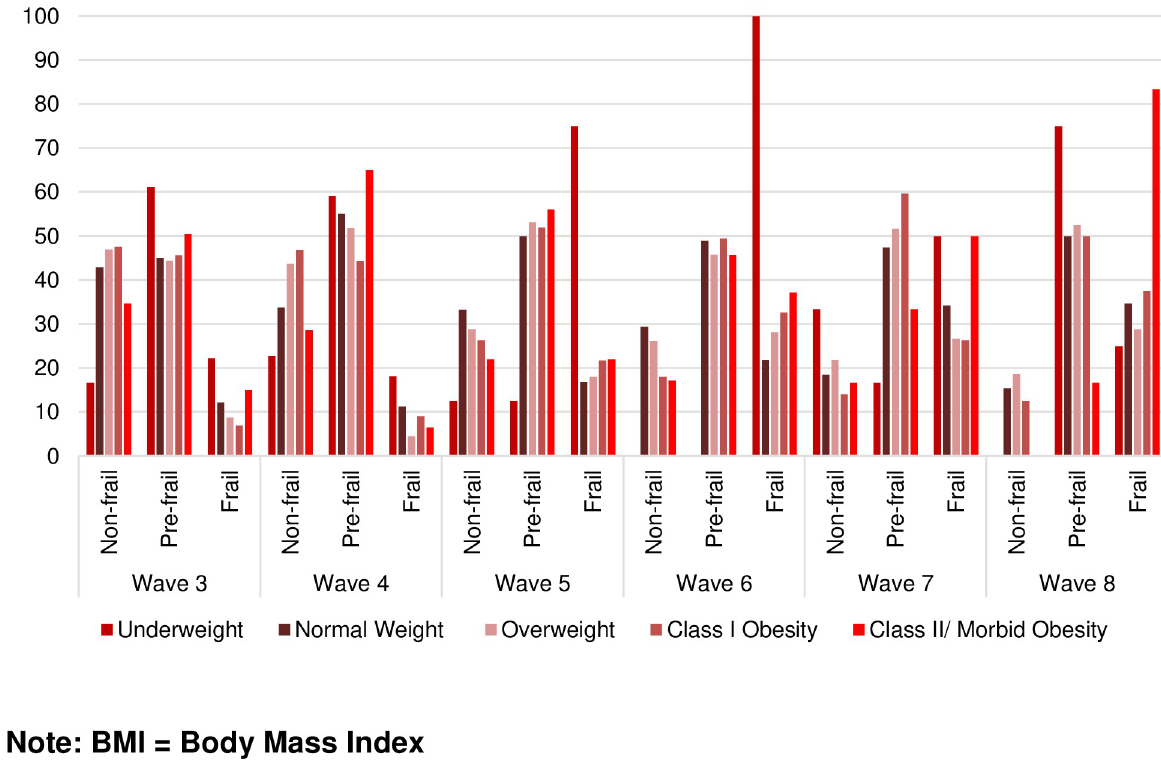
Fig 2. Percent of non-frail, pre-frail, and frailty by BMI categories over time among non-frail older Mexican Americans at baseline (N = 1,648).